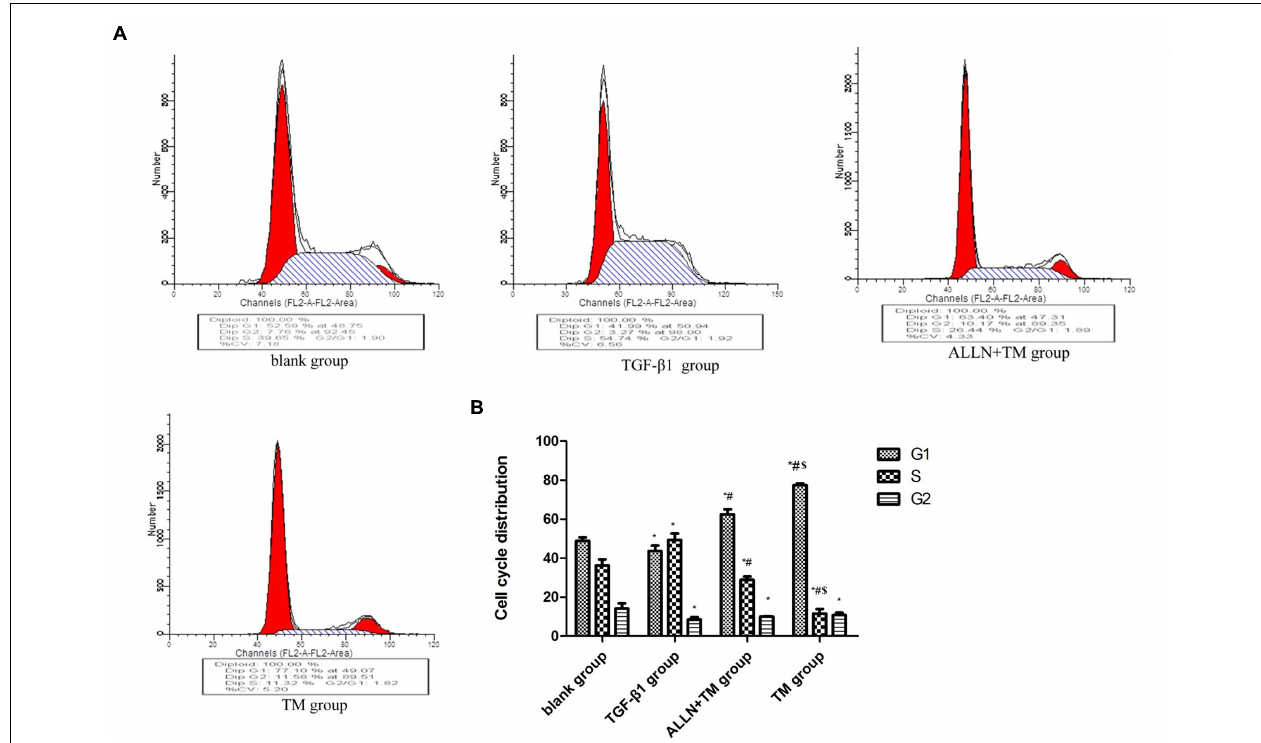
FIGURE 3 | The cell cycle changes in HSC in each group. After treated with TGF- β 1, ALLN, and TM, HSC cell cycle of each group was determined by flow cytometric analysis. (A) Figures represent the distribution of different cell cycle phase. (B) Columns represent the percentages of the corresponding cell cycle phase. (* p < 0.05 compared with the blank group; # p < 0.05 compared with the TGF- β 1 group; $ p < 0.05 compared with the ALLN + TM group). and further cultured in the incubator for 20 min after adding 1 ml complete medium. The excitation wavelength of the confocal microscope was set as 488 nm, and the emission wavelength was set as 530 nm. FV10-ASW 4.0 Viewer was used to process the image data. Six cells were selected from each image to calculate the fluorescence